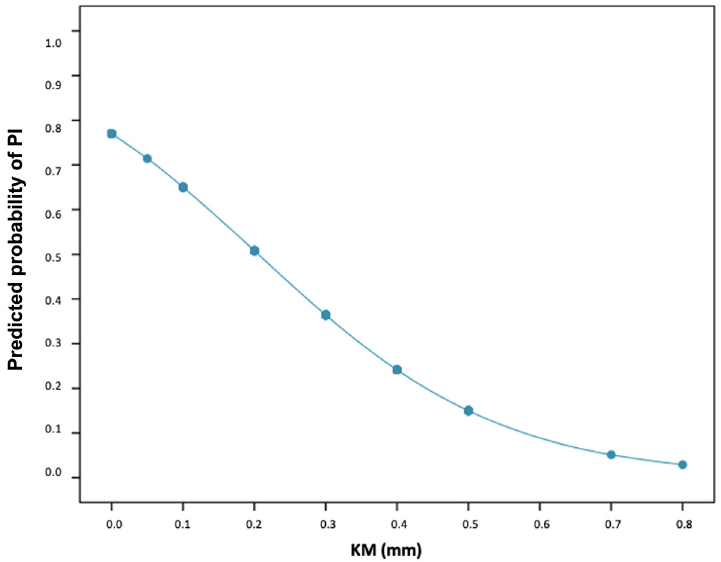
Figure 6. Decreased probability of peri-implantitis in terms of mm of keratinized mucosa. PI (peri- implantitis), KM (keratinized mucosa).